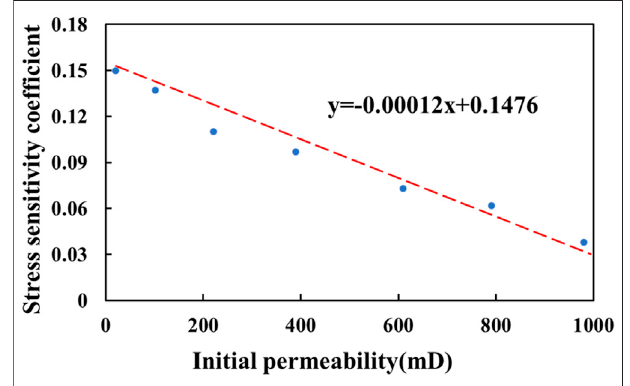
FIGURE 3 | Relationship between stress sensitivity coef fi cient and initial fracture